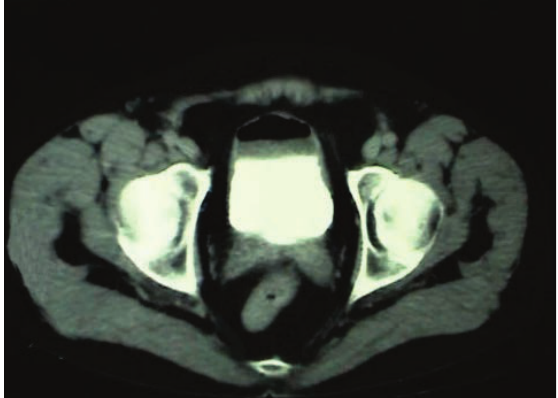
Figure 1. CT scan showed air/fluid level in the bladder and slight anomalies and thickening of the bladder wall, which was closely adherent to the sigmoid wall.